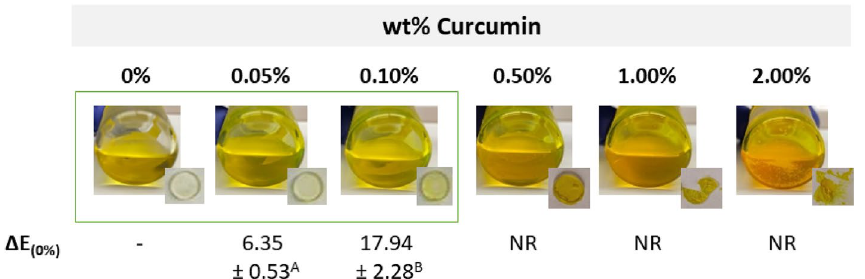
Figure 2. Images of the pre-polymerized blends with inset images of the experimental resin-blend disks after 60 s light curing on each side. The disks were classified as completely polymerized for the 0%, 0.05% and 0.10%, inconsistent for the 0.5%, or incomplete for 1% and 2%. The difference in colour (∆E (0%) ) is reported for the 0, 0.05 and 0.10 wt% curcumin-loaded disks relative to the unloaded (0% curcumin) disks; the colour of disks of higher concentration was not recorded (NR). Means that are detectably different (p < 0.05) are assigned different